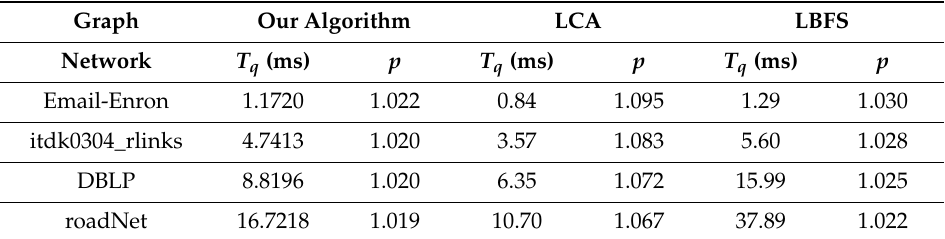
Table 3. Results from LCA, LBFS and our